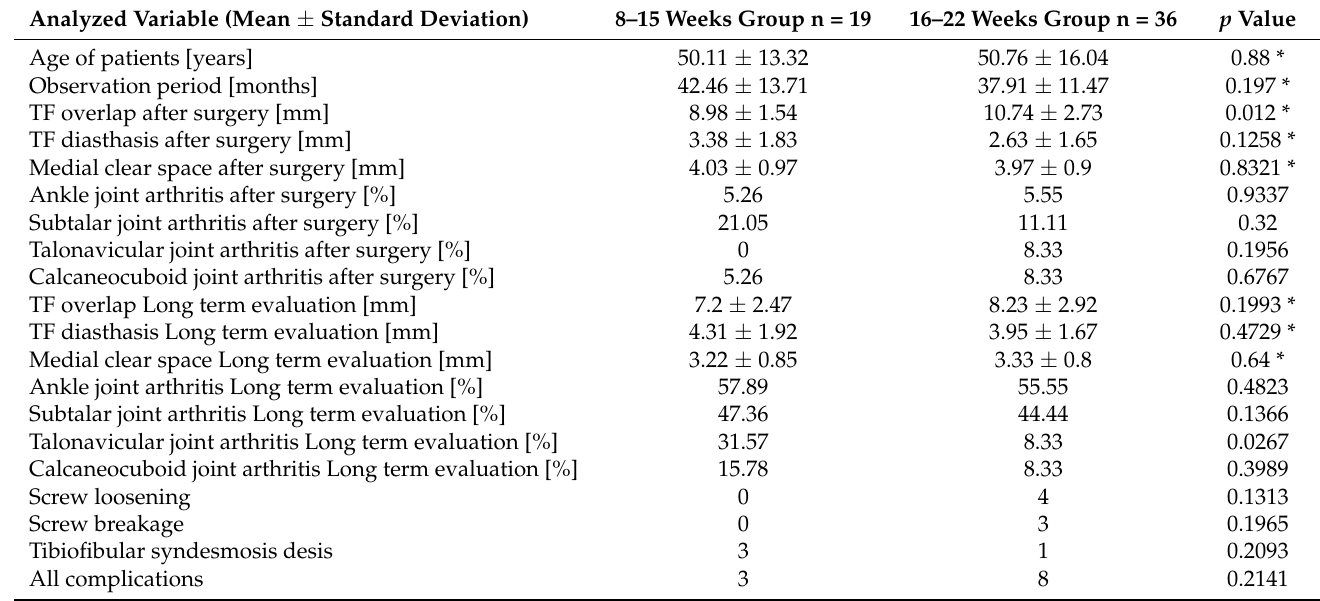
Table 2. Detailed results after screw hold time 8–15 weeks and 16–22 weeks.